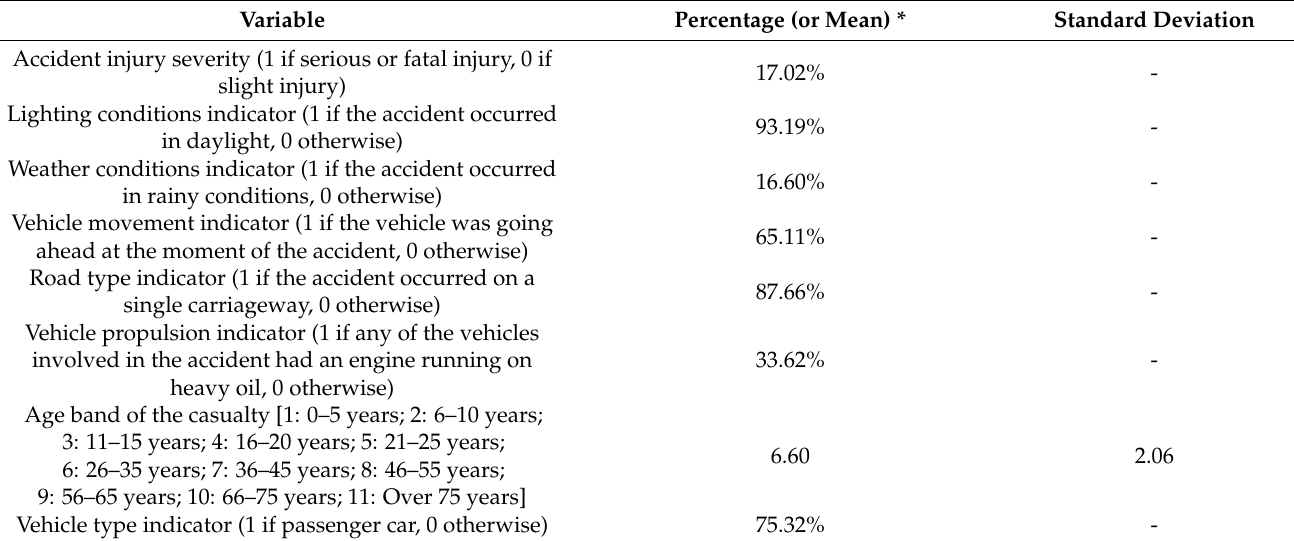
Table 3. Descriptive statistics of the variables included in the model of accident injury severities for rural